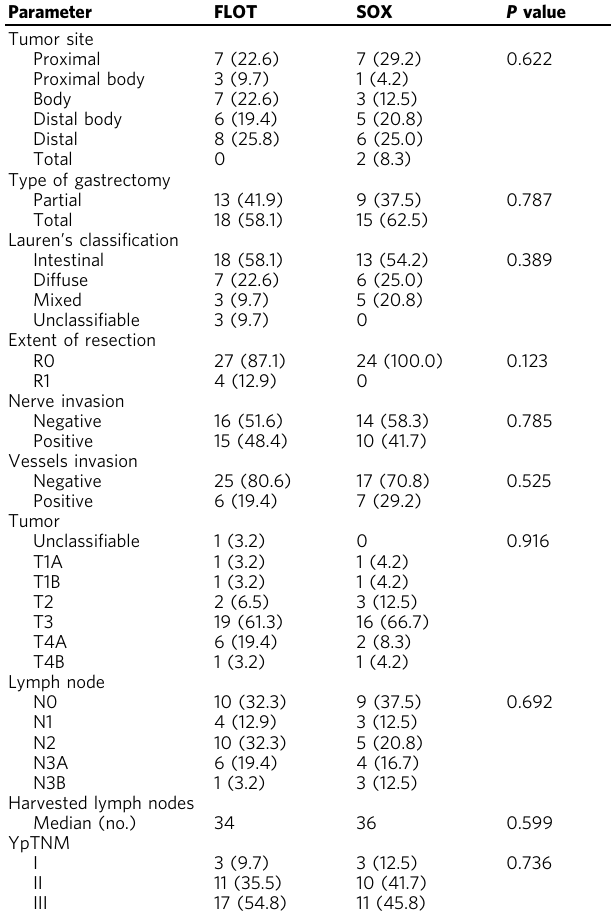
Table 3 Post neoadjuvant chemotherapy (NAC) CT